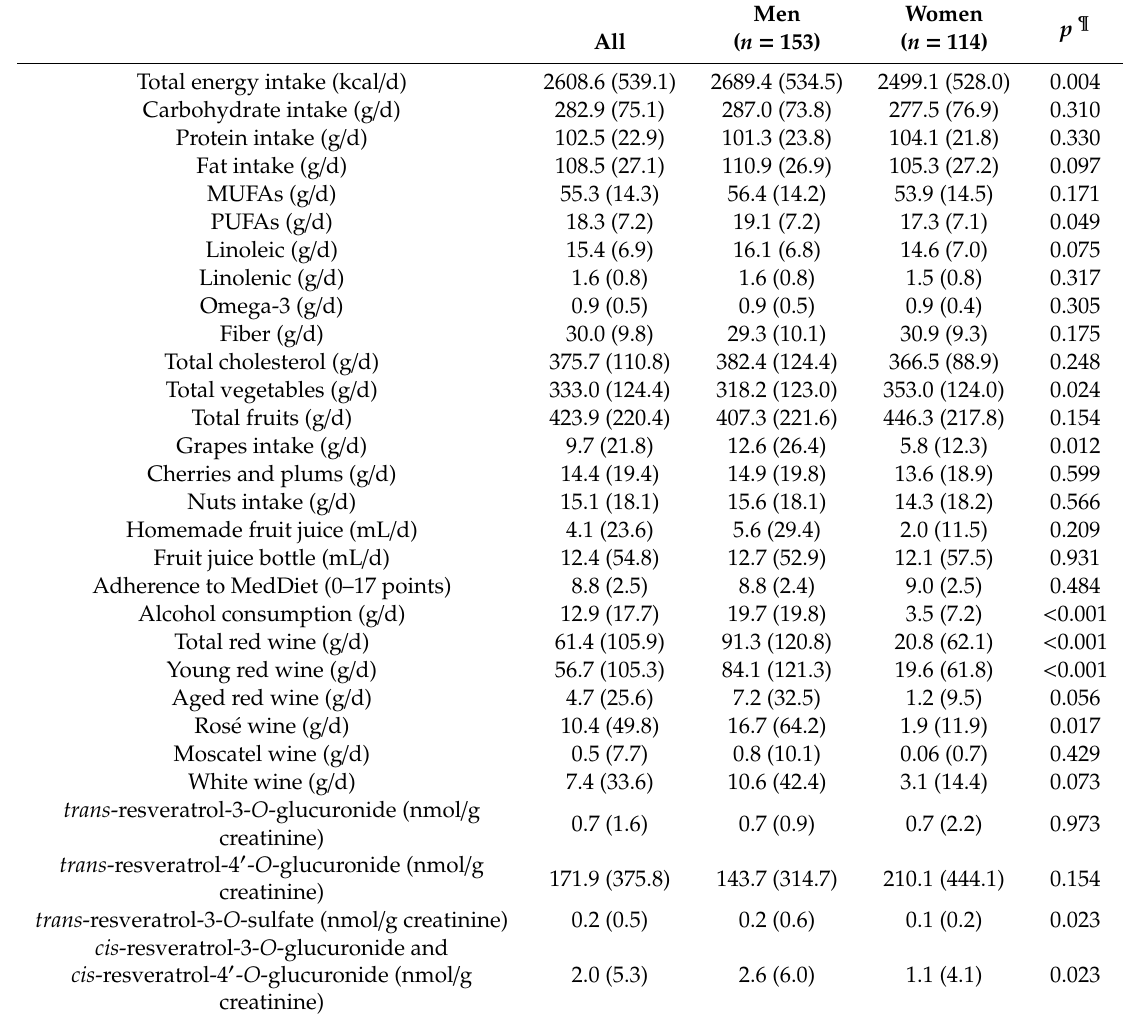
Table 2. Dietary intake and urine resveratrol metabolites in participants diagnosed with MetS by sex at